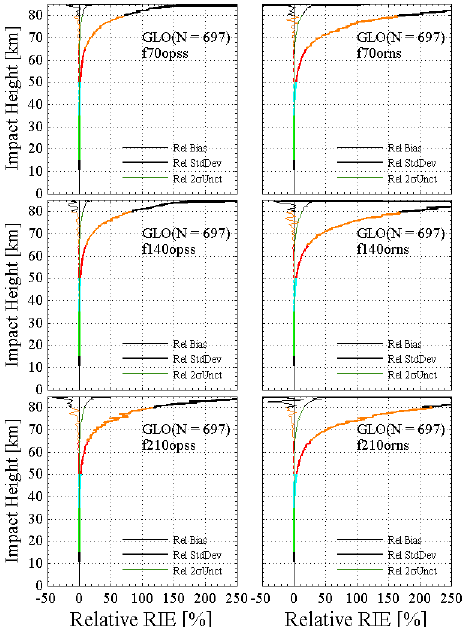
Figure 10. Relative RIEs and their statistics for the GLO ensem- ble “opss” (left column) and “orns” (right column) data sets. The bias (thin lines), standard deviation (thick lines) and the bias’ 95% confidence level uncertainty (dark green lines) are